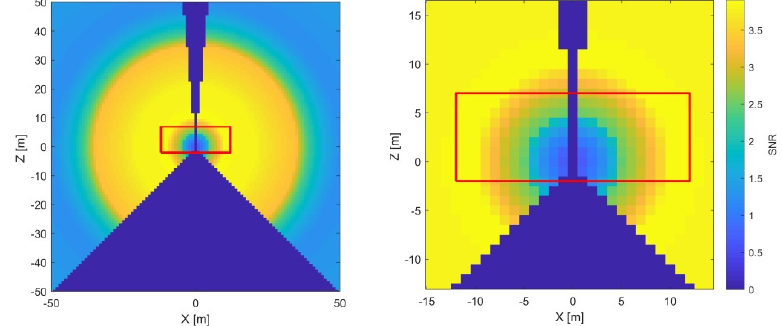
Figure 7. Signal to noise ratio (SNR) for x 2 on a vertical plane—full field of view ( left ) and the close-up ( right ). The red square—the limitations of the cross-section dimensions of the facility used in the empirical experiment.